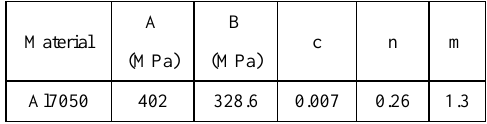
Table1. The coefficient of J-C constitutive equation